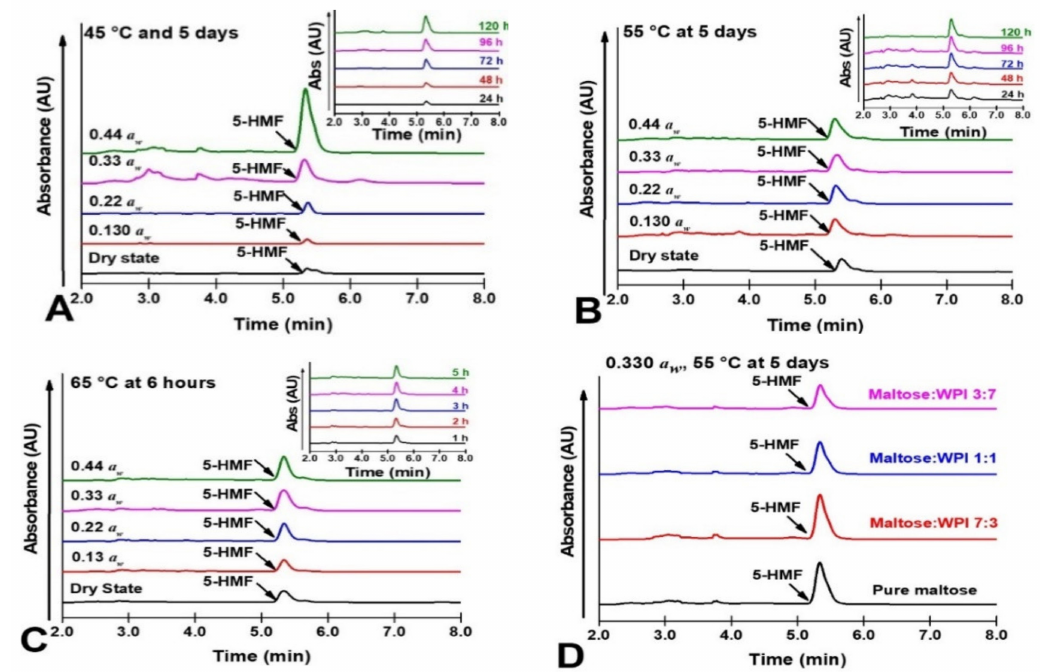
Figure 4. The HPLC chromatograms for amorphous maltose/WPI matrix at the studied storage conditions (dry state~0.44 a w and 45~65 ◦ C) shown in ( A – D ) demonstrated the HPLC chromatograms of pure maltose and maltose/WPI mixture (7:3, 1:1, and 3:7, w / w ) at 0.33 a w and 55 ◦ C. Time- dependent curve for pure maltose (0.33 a w ) is shown in ( A – C ). The peaks in approximately 5.3 min were identified and integrated to represent the 5-HMF accumulation